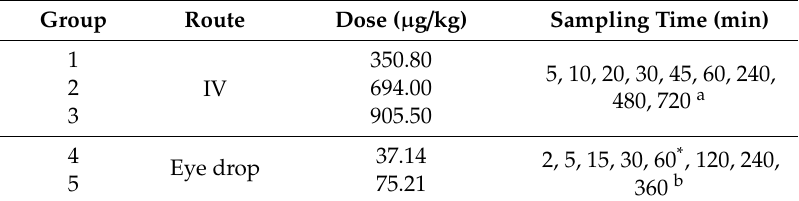
Table 5. Experimental design of PK studies in